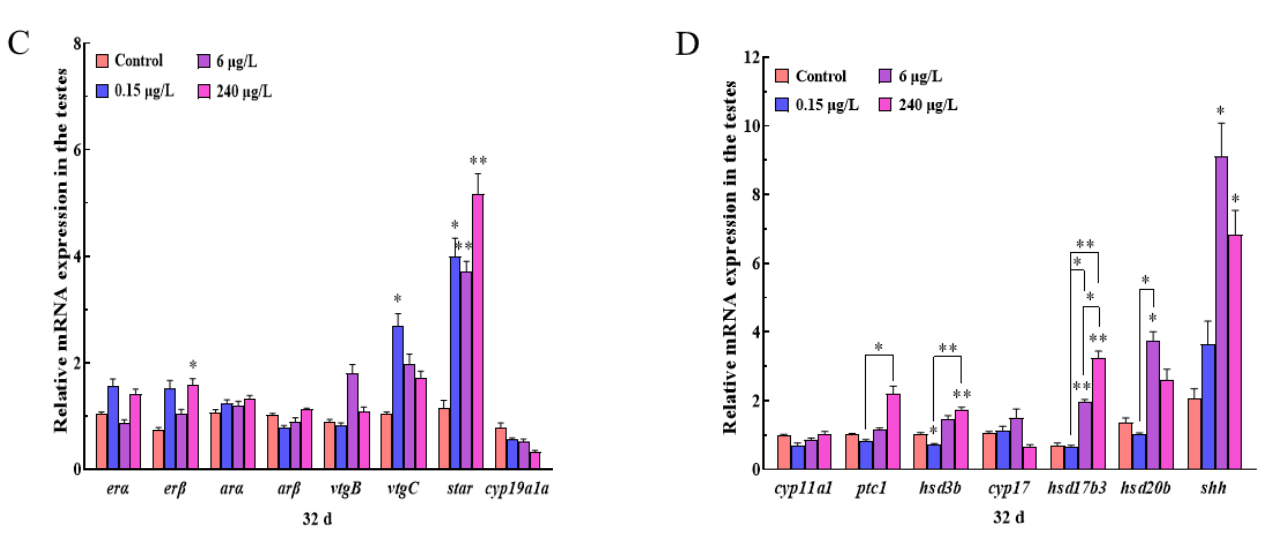
Figure 4. Transcriptional levels of HPGL axis related genes in the testes of male mosquitofish suffered from 0, 0.15, 6 and 240 µ g/L PrP treatment for 4d ( A , B ) and 32d ( C , D ), respectively. Data were analyzed by t -test and Tukey’s multiple comparisons. Asterisks (*) above the bars indicate statistical significance (* p < 0.05, ** p < 0.01, △ p < 0.08). erα , estrogen receptor alpha; erβ , estrogen receptor beta; arα , androgen receptor alpha; arβ , androgen receptor beta; vtgB , vitellogenin B; vtgC , vitellogenin C; star , steroidogenic acute regulatory protein; cyp19a1a , cytochrome P450, family 19, subfamily A, pol- ypeptide 1a; cyp11a1 , cytochrome P450 family 11 subfamily A member 1; ptc1 , patched 1; hsd3b , hydroxy-delta-5-steroid dehydrogenase, 3 beta- and steroid delta-isomerase cluster; cyp17 , steroid 17-alpha-hydroxylase/17,20 lyase, hsd17b3 , hydroxysteroid 17-beta dehydrogenase 3, hsd20b , 20β -hydroxysteroid dehydrogenase type, shh , sonic hedgehog.